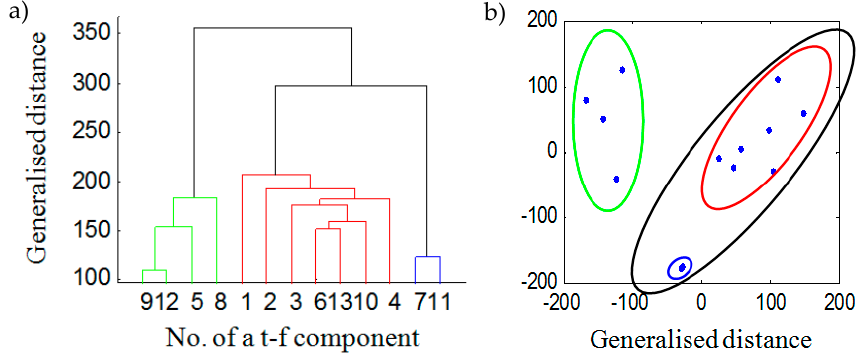
Figure 6. The results of hierarchical clustering for the Euclidean distance for 𝑇𝐹𝐷 (cid:3036) components ( a ),